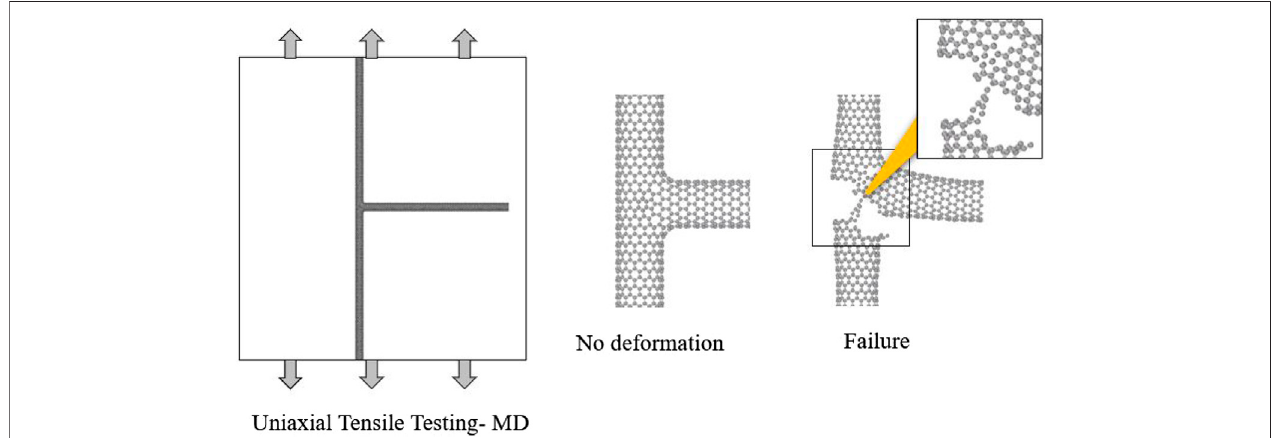
FIGURE 12 | 3T-Junction under tensile loading and the tensile strain is applied until failure.